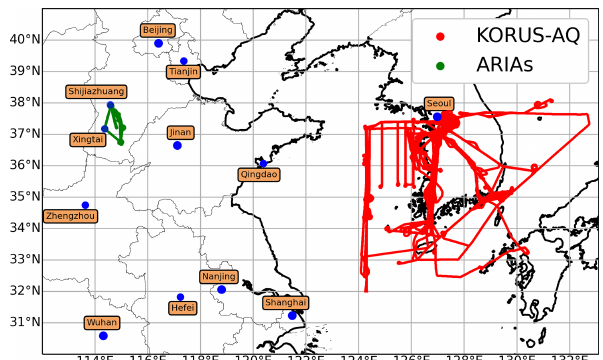
Figure 1. Location of all the KORUS-AQ DC-8 1min merge mea- surements (red dots) and of the ARIAs Y-12 1min merge measure- ments (green dots). The location of some major cities is also indi- cated (blue